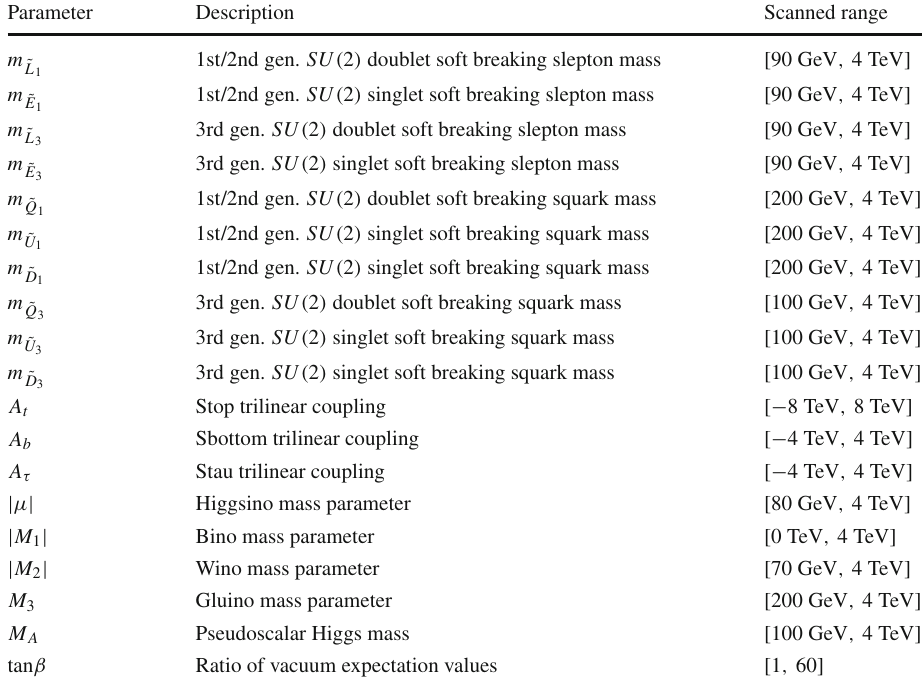
Table 2 Variable input parameters of the ATLAS pMSSM scan and the range over which these parameters are scanned